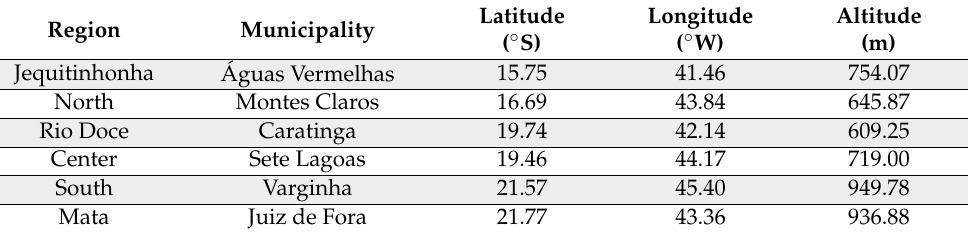
Table 1. Geographic coordinates of the selected municipalities of Minas Gerais State, Brazil.